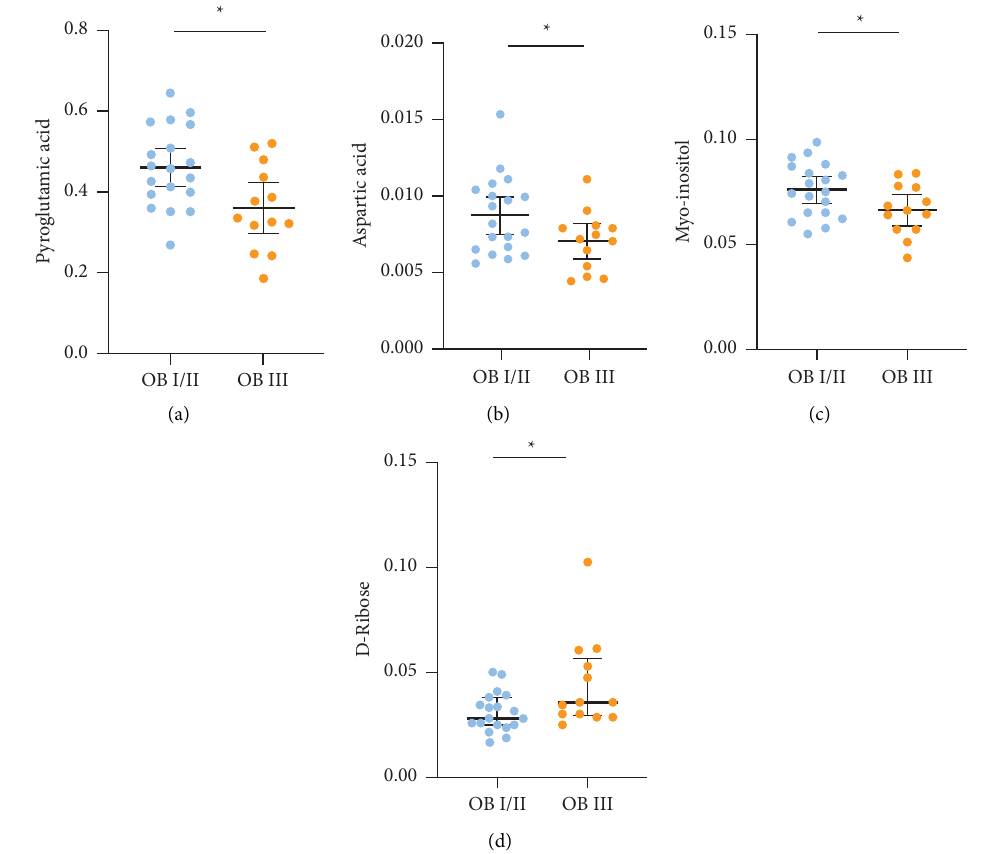
Figure 5: Relative abundance of metabolites between groups. Te relative abundance of pyroglutamic acid (a), aspartic acid (b), myoinositol (c), and D-ribose (d) was compared between groups using GzLM analysis. Data are shown with respective mean and IC95 for normal distribution (a–c) or median and interquartile for variables that do not have a normal distribution (d). OB I/II ( n � 19) and OB III ( n � 13). ∗ p < 0 . 05.